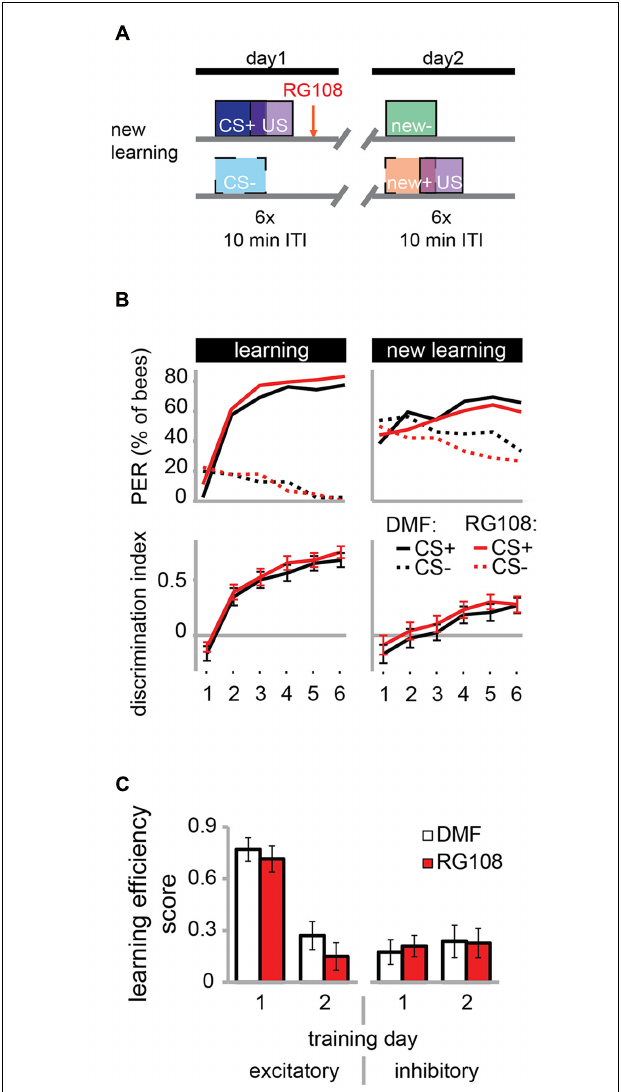
FIGURE 4 | DNA methyltransferases do not regulate the learning of new odors. (A) To confirm that Dnmts are necessary for efficient relearning of previously learned stimuli, but not for acquisition in general, we trained bees with a differential conditioning paradigm as in Figure 3 , but trained them with two new odors on day 2. (B) Bees learned to discriminate the two new odors with and without active Dnmts. (C) Neither excitatory nor inhibitory components of learning were impaired by Dnmt inhibition on the second training day. n (DMF) = 39, n (RG108) =